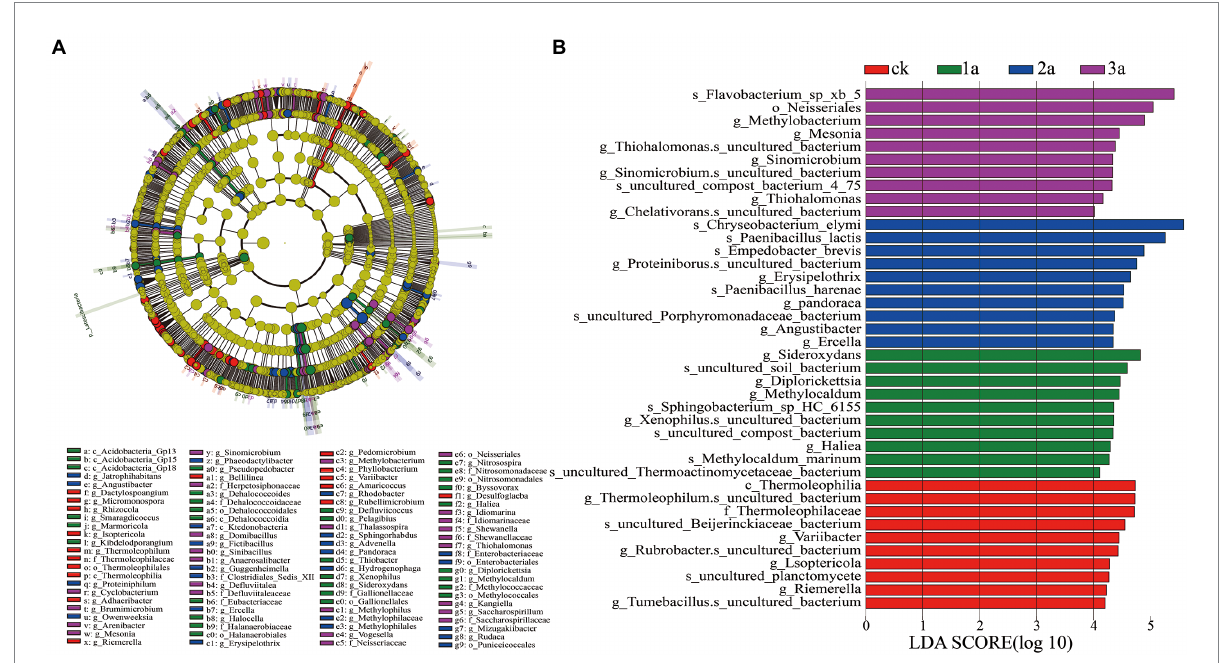
FIGURE 5 Evolutionary branch diagram of bacterial community differences (A) . Indicator microbes in groups with linear discriminant analysis (LDA) scores greater than 4 (B) . CK, 1a, 2a, and 3a represent greenhouses consecutively planted for 0, 1, 2, and 3 years, respectively. Each circle represents all